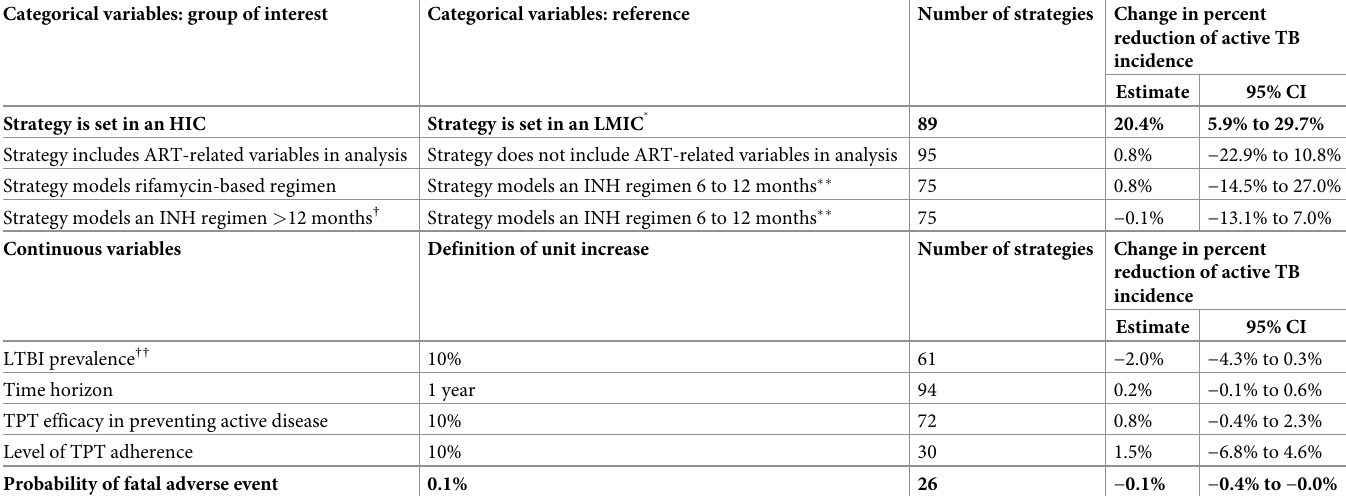
Table 2. Univariable regression models: percent reduction in active TB incidence comparing TPT to no